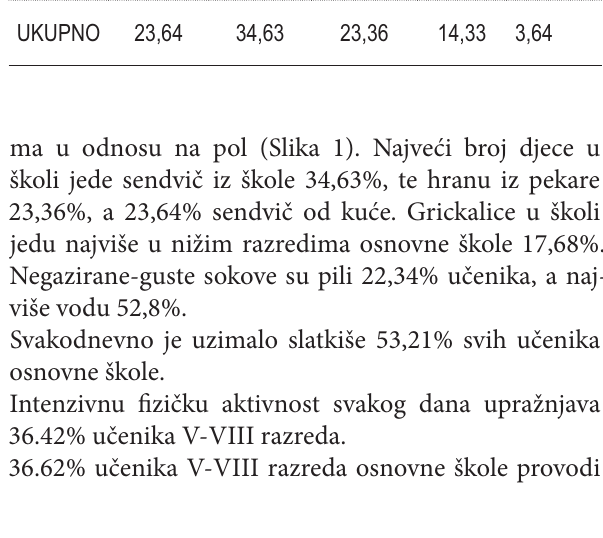
Svakodnevno je uzimalo slatkiše 53,21% svih učenika osnovne škole. Intenzivnu fi zičku aktivnost svakog dana upražnjava 36.42% učenika V-VIII razreda. 36.62% učenika V-VIII razreda osnovne škole provodi